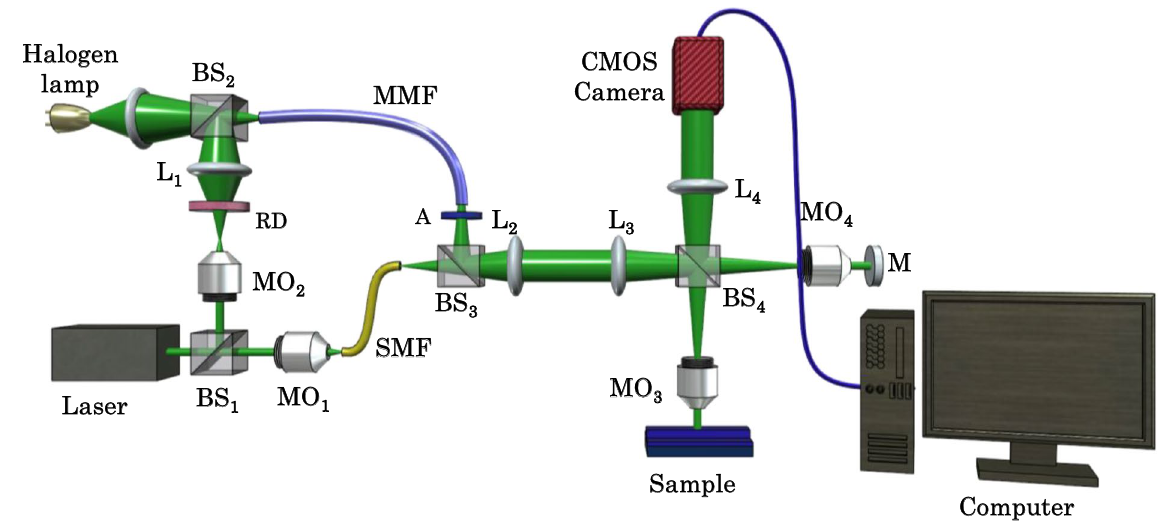
Figure 8. Schematic diagram of the QPM system. MO 1–4 Microscope objectives, BS 1–4 beam splitters, L 1–4 Lenses, RD rotating diffuser, MMF multi-mode fiber, SMF single mode fiber, A bandpass filter, M mirror, CMOS complementary metal oxide semiconductor